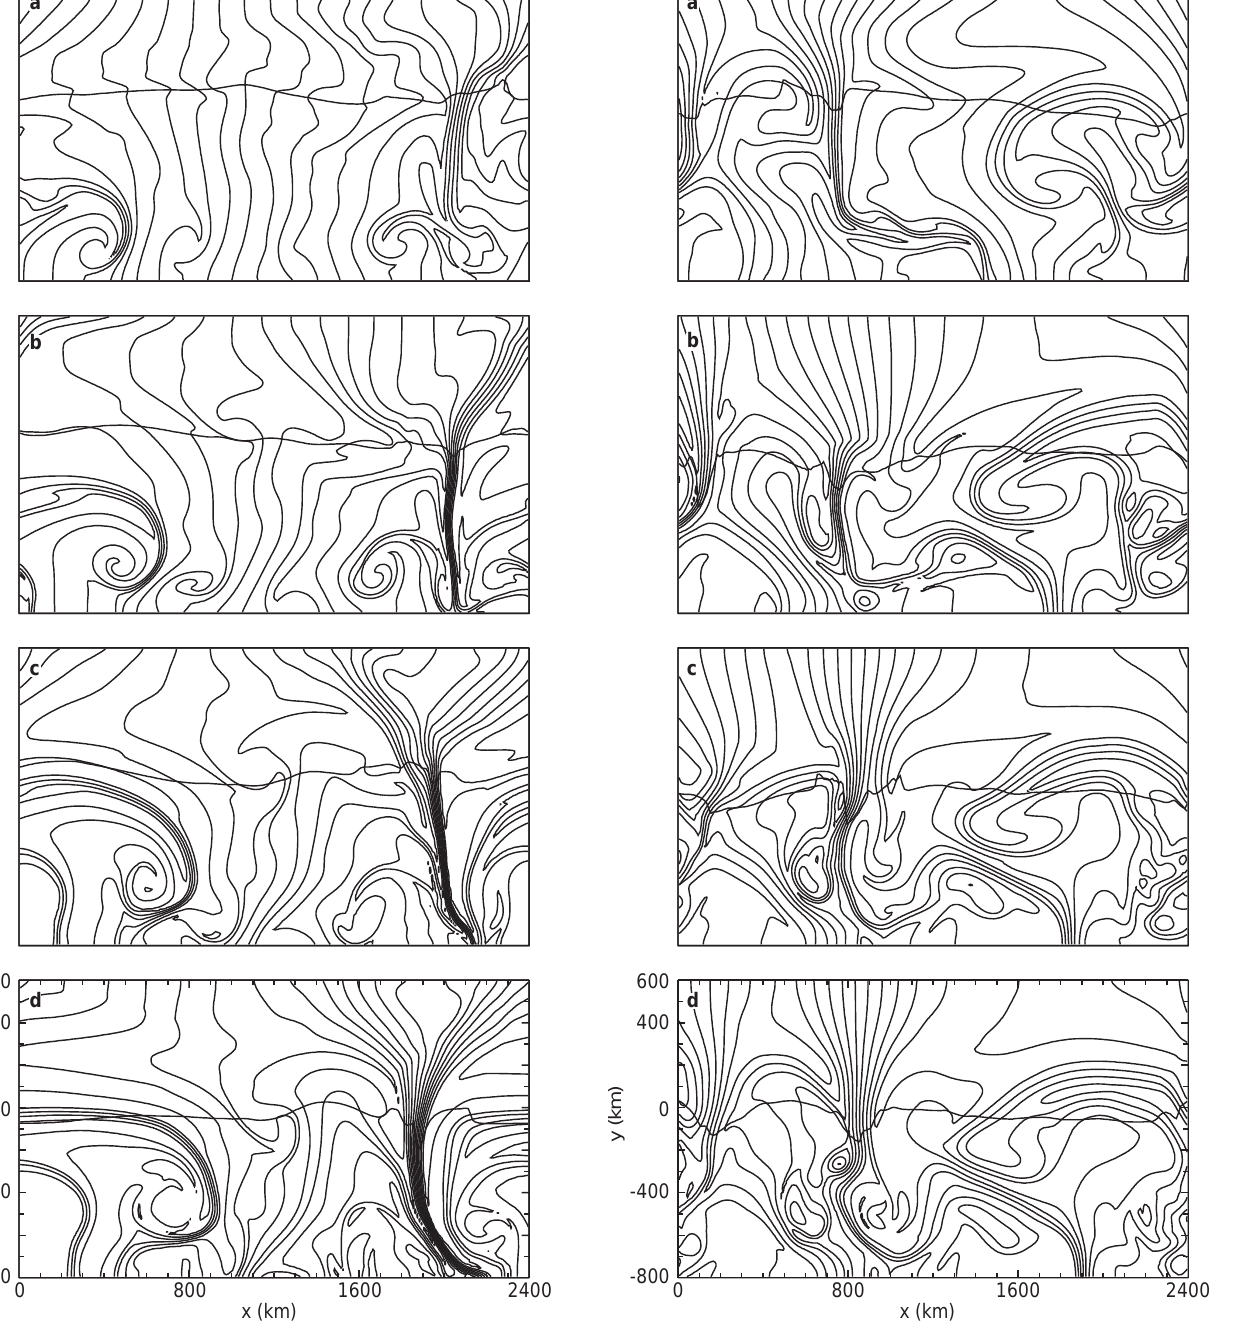
Fig. 1. Strong vertical and weaker horizontal magnetic field arising in a MHD simulation under conditions prevailing in the solar photosphere. The panels on the left-hand side show magnetic field lines at the times 60 s, 115 s, 175 s, and 230 s after imposing an initially homogeneous magnetic field of 100 G. The panels on the right-hand side correspond to 100 s, 200 s, 250 s, and 300 s and an initial field of 200 G, starting from a di(cid:128)erent convection pattern. The direction of the x -coordinate is parallel to the solar surface, spanning